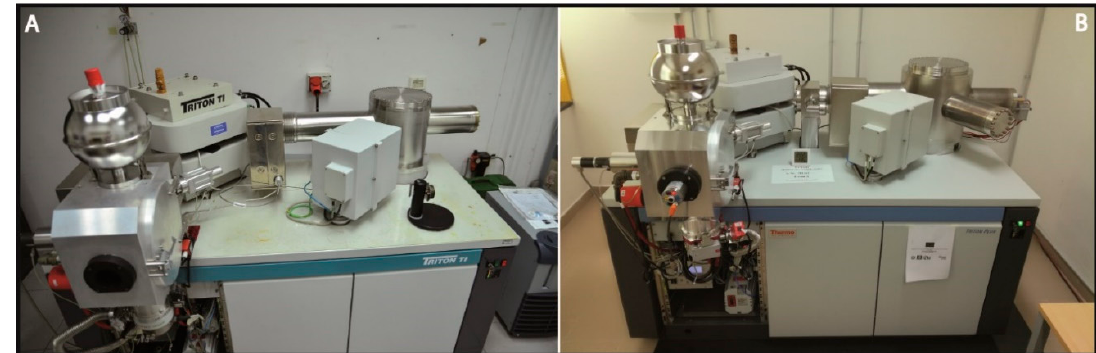
Figure 6. Photograph of the thermal ionization mass spectrometers: ( A ) the Triton TI at INGV, OV, and ( B ) the Triton Plus at DiSTAR.